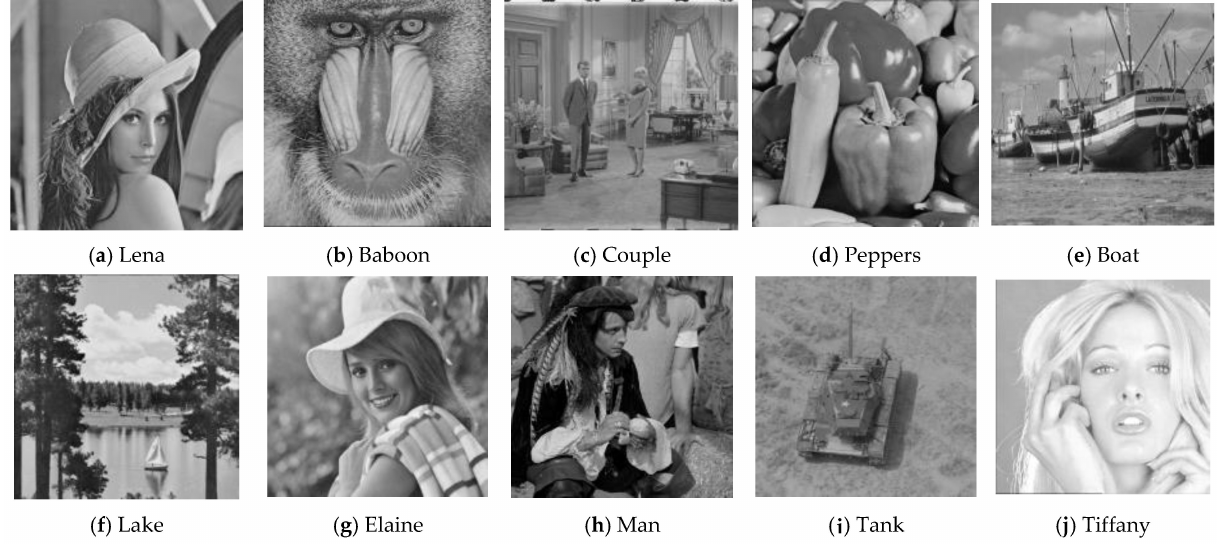
Figure 2. Ten typical test images.